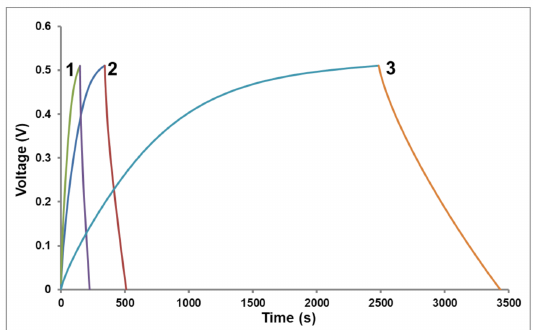
Figure 10. Variation of the voltage of a capacitor made by two identical carbon cloth electrodes each carryng 5 mg of Na–BC under galvanostatic conditions and by applying the charging–discharging procedure. The corresponding current densities in mA cm − 2 were: (1) 2; (2) 1; and (3) 0.2. The electrolyte was 0.5 M aqueous NaOH containing 5% v/v ethanol. The capacitance of each electrode (i.e., each electrochemical double layer) was 156 F g − 1